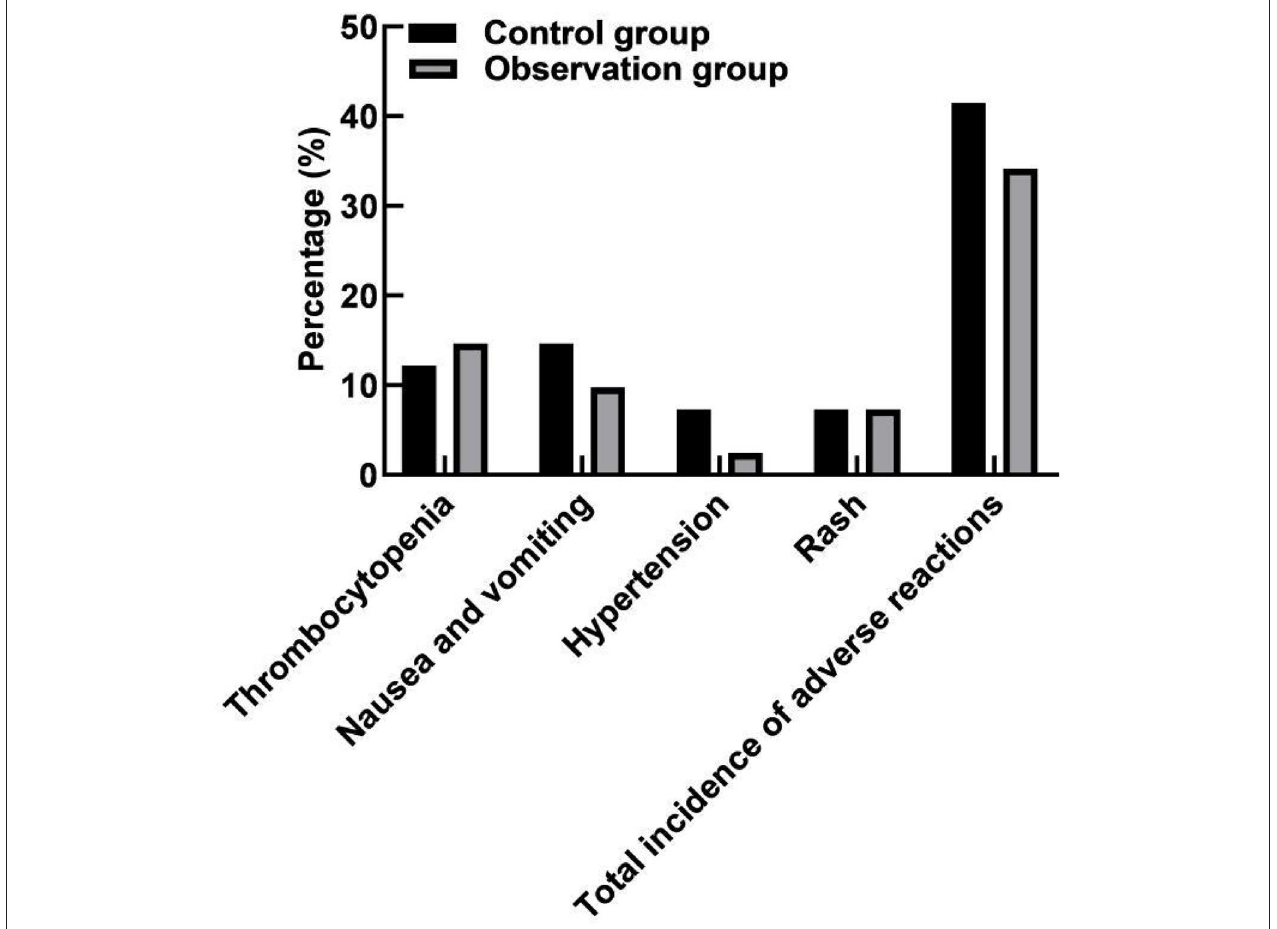
FIGURE 5 | Comparison of adverse reactions between the two